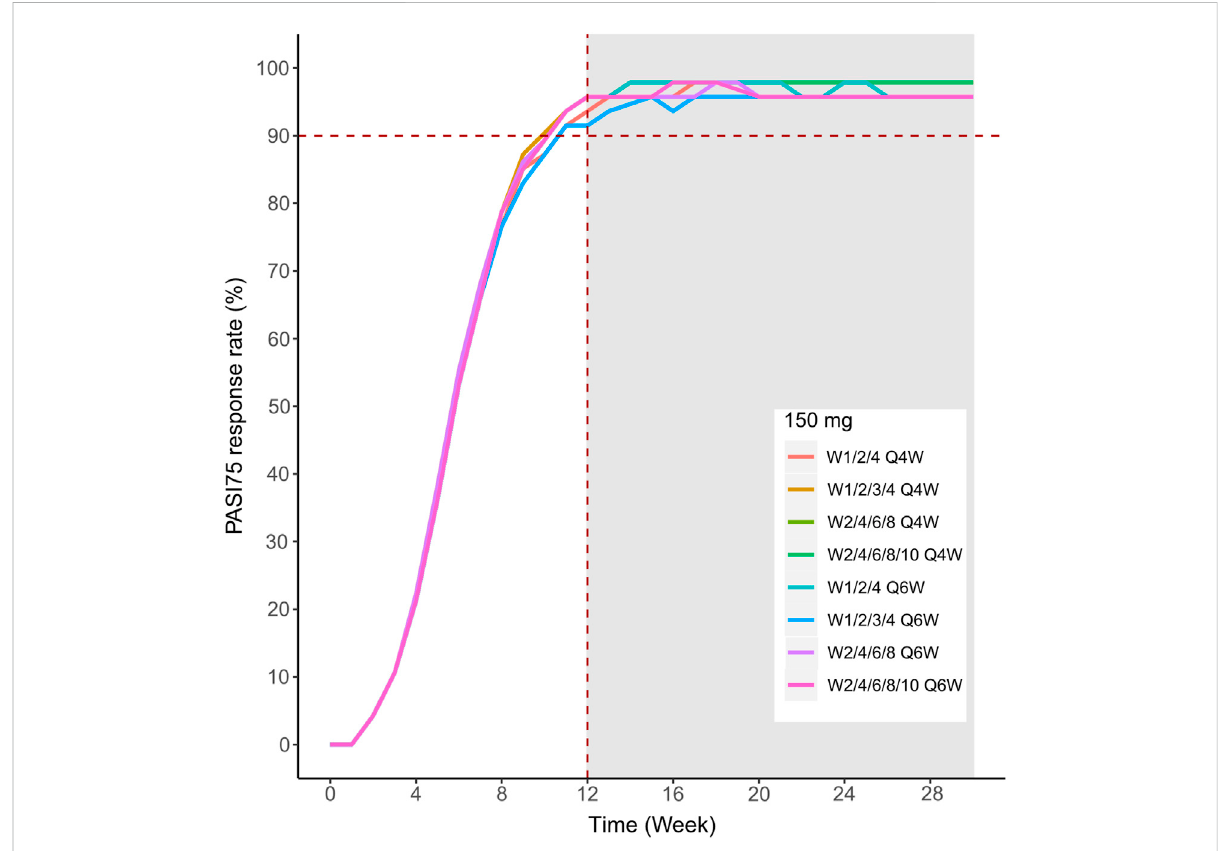
FIGURE 10 Simulated median PASI75 and PASI90 response rates under different dose regimens using the fi nal population PK/PD model. PASI75 response rate of 150 mg in the eight dosing regimens.